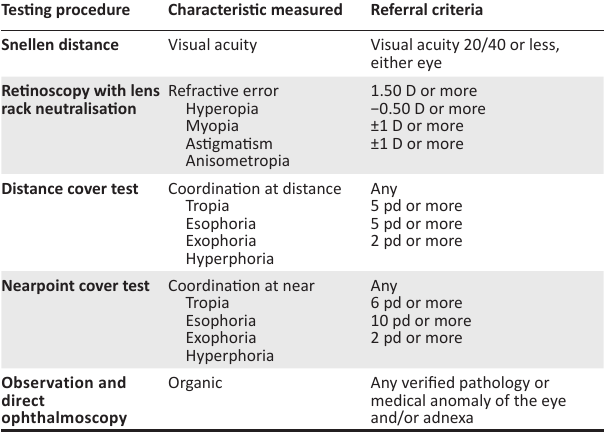
TABLE 1: Clinical procedures and referral criteria for the modified clinical techniques. Testing